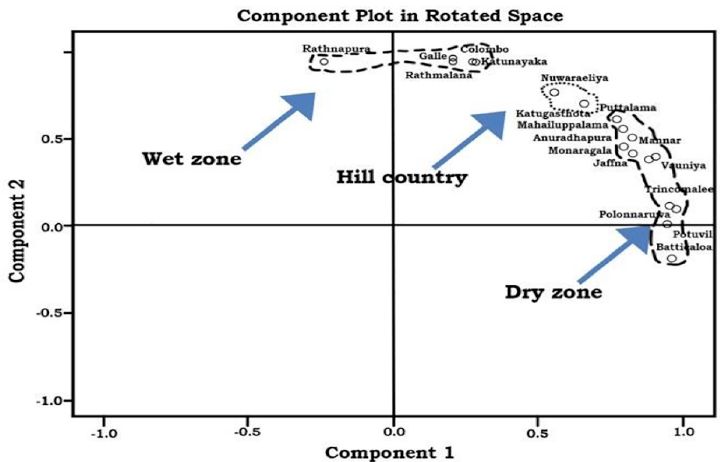
Fig 2. Classification of Sri Lankan climatic zones based on rainfall represented as a component plot in rotated space.